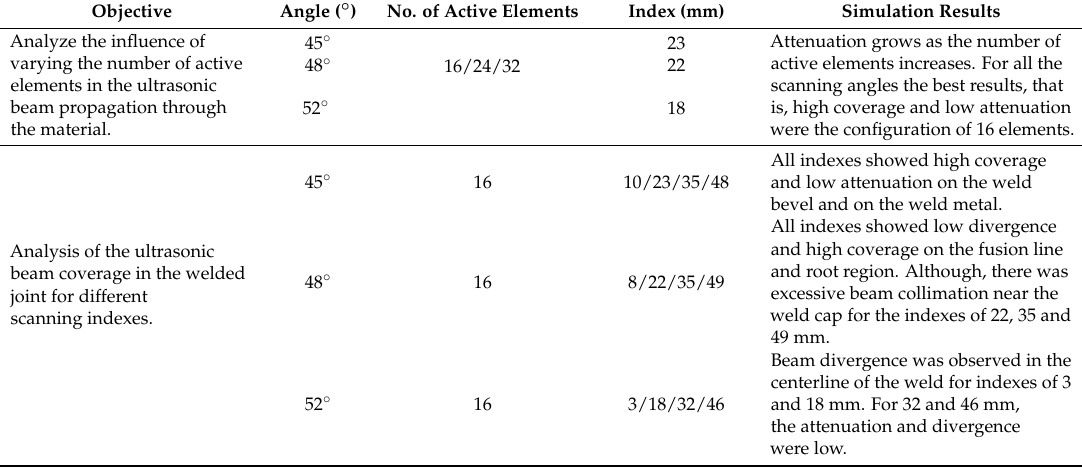
Table 8. Summary of the simulation results.